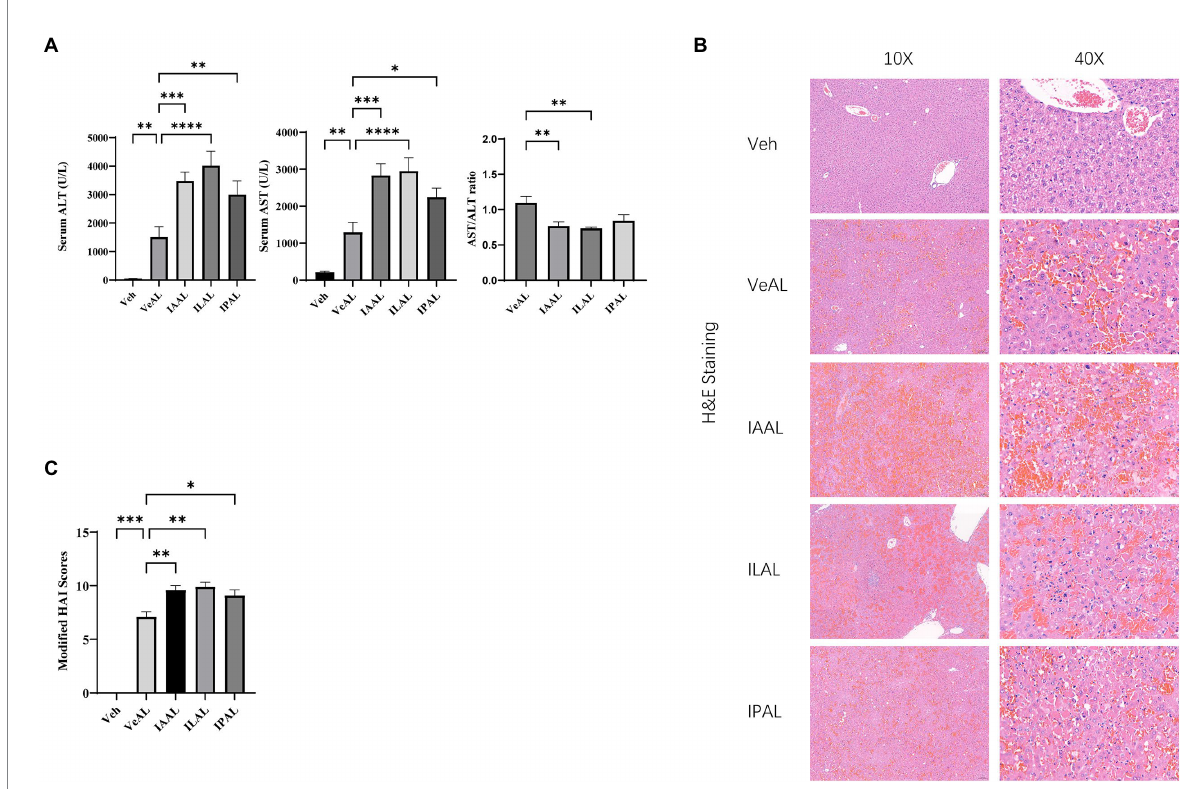
FIGURE 1 Pretreatment of indole derivatives sensitize mice to D-GalN/LPS induced-liver injury. (A) Serum levels of ALT and AST in all groups, and AST/ALT ratios in four ALF groups. (B) Representative liver H&E staining (original magnification × 10/40, scale bar = 100 μ m/20 μ m). (C) Liver pathological modified HAI. The data are presented as the mean ± SEM. * p < 0.05; ** p < 0.01; *** p < 0.001 and **** p < 0.0001 for the comparison. Veh, Vehicle (saline control); VeAL, Vehicle + D-GalN/LPS; IAAL, IAA + D-GalN/LPS; ILAL, ILA + D-GalN/LPS; IPAL, IPA + D-GalN/LPS. n = 10 in each